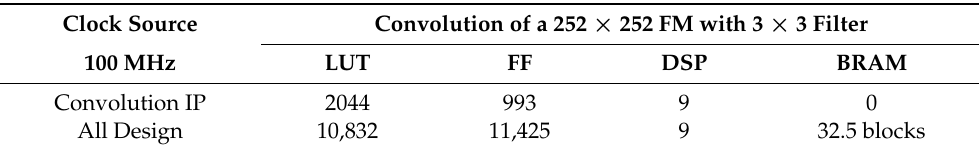
Table 1. Resources used for convolution IP and all integrated design (central direct memory access (CDMA) module, blocks RAM and Zynq PS).